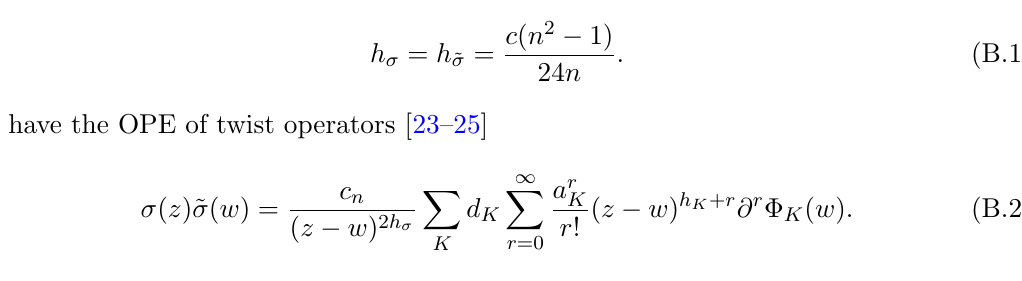
table 2. The normalization factors (cid:11) operators can also be found in [54].